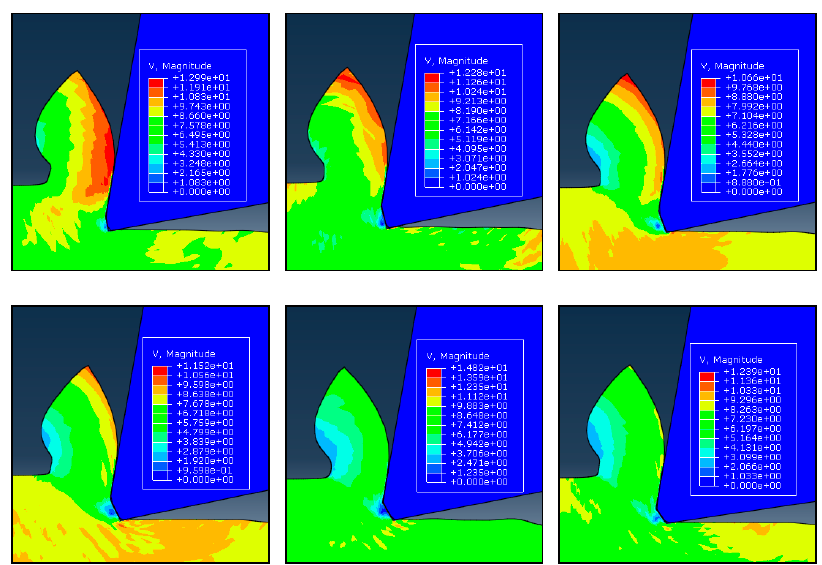
Figure 7. Velocity fields of the simulation with different chamfer angles. From top and left: −10°, −15°, −20°, −25°, −30°, and −35°.